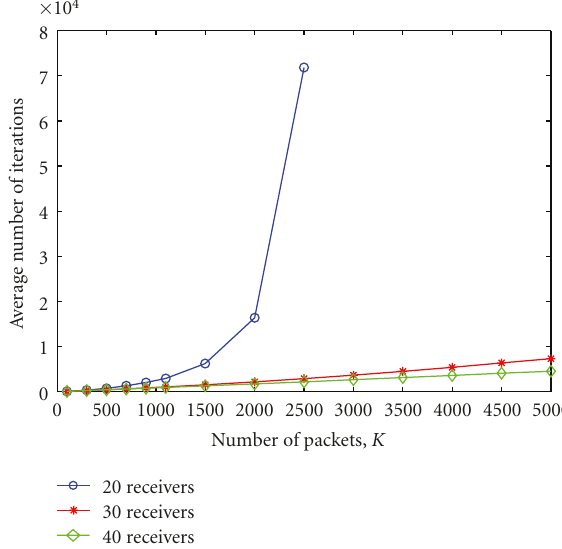
Figure 5: Average number of recursions in Algorithm 1 and Heuristics 1–3. The maximum number of recursions for both Heuristic 2 and 3 is set to 100. By referring to Figure 3, we observe that for small number of receivers, Heuristics 2-3 can provide same decoding delays at a fraction of computational complexity.